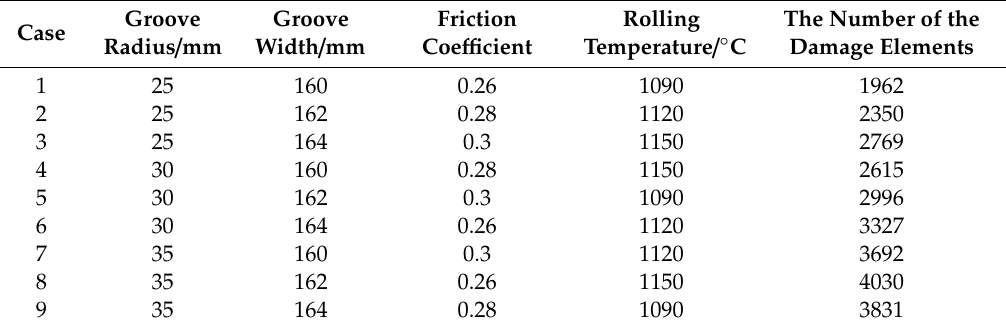
Table 5. The simulation results using the orthogonal test method.